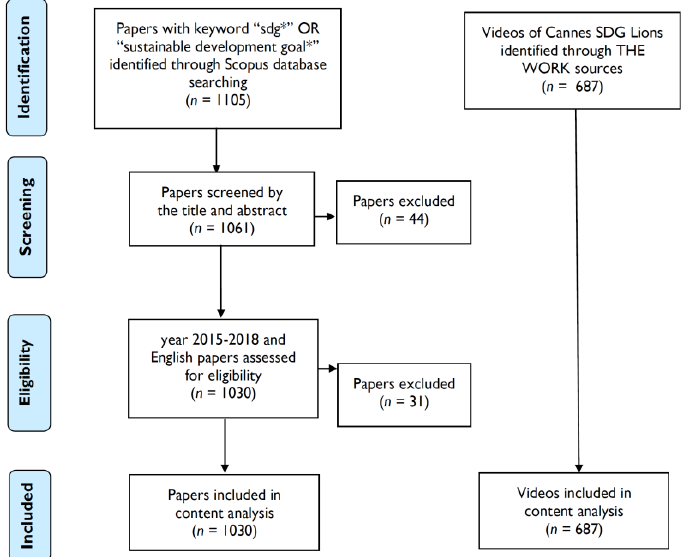
Figure 1. The flow diagram of the present systematic review study.